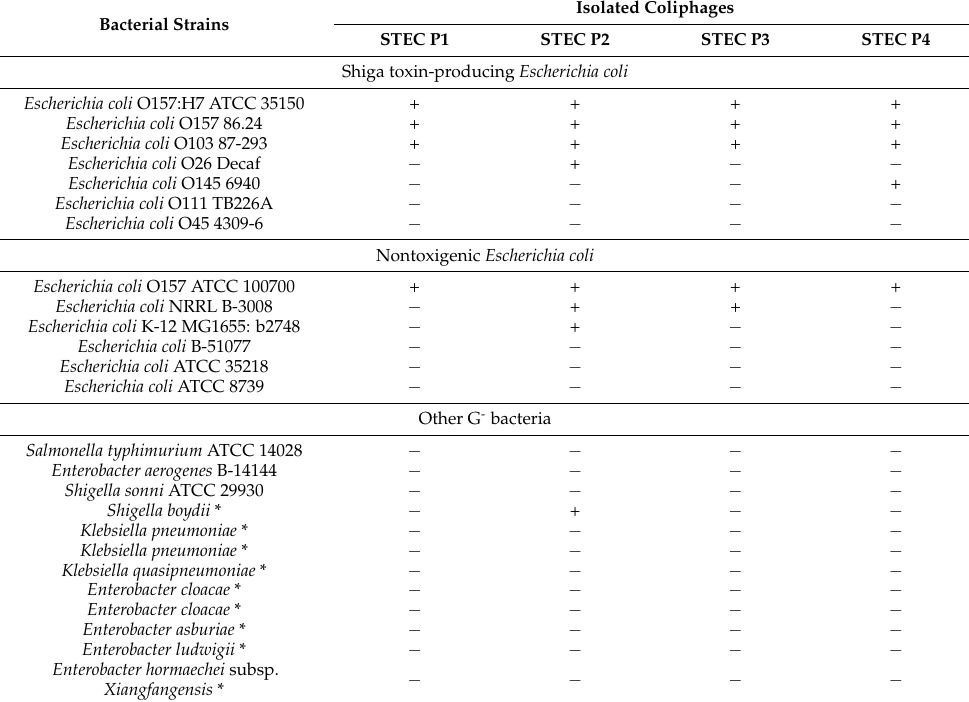
Table 1. Host range of selected STEC phages.